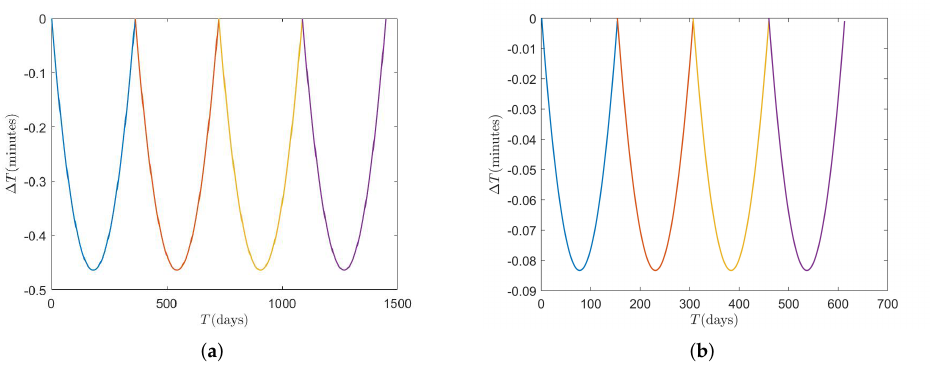
Figure 4. The local time drift ∆ ˜ T after four inclination biased periods when the limited extremum of local time drift ∆ T L = 0.1 min ( a ) ∆ a 0 = 1 km, ∆ i 0 = 1 × 10 − 5 deg, − ( β s − Ω ) = − 135 deg, control period T P = 363 days; ( b ) ∆ a 0 = 1 km, ∆ i 0 = 5 × 10 − 5 deg, − ( β s − Ω ) = − 135 deg, control period T P = 154